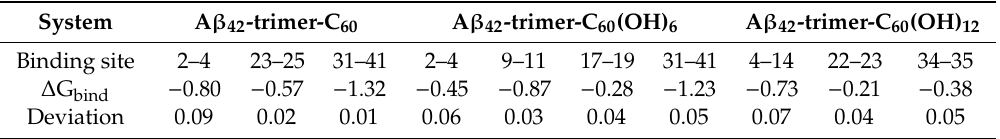
Table 2. Free energy (in kcal / mol) of di ff erent binding sites for the fullerene / fullerenol molecule to A β 42